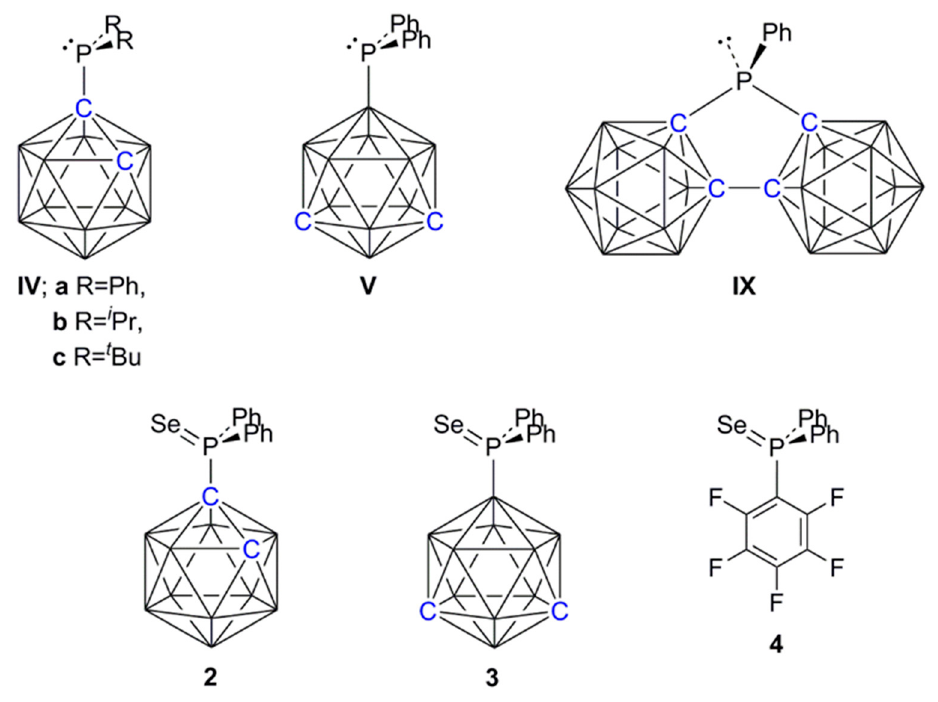
Scheme 2. Line diagrams of key species.